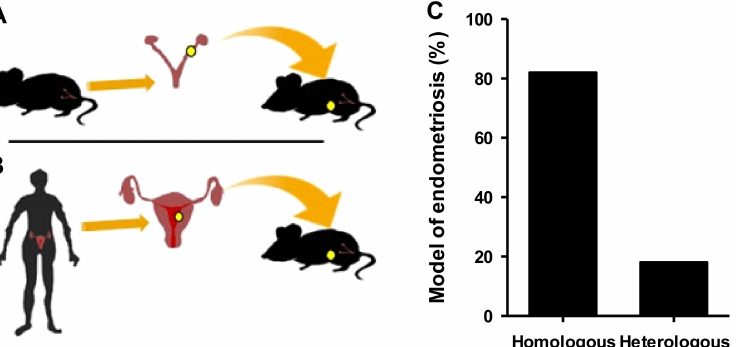
Figure 2. Endometriosis models in rodents. Schematic representation of homologous ( A ) and heterol- ogous ( B ) endometriosis models. ( C ) Percentage of articles reporting homologous vs. heterologous disease induction in these two main models of endometriosis from 931 papers